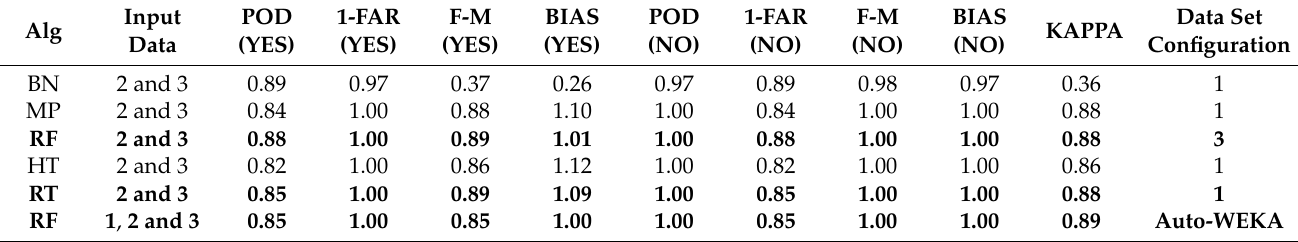
Table 4. Statistical test results of 15 min Vis forecasts ≤ 3700 m for the five algorithms (Alg) selected with input from SODAR (source 1), ASWS (source 2) and observer (source 3). The satisfactory algorithm result is in bold. Input Alg Data